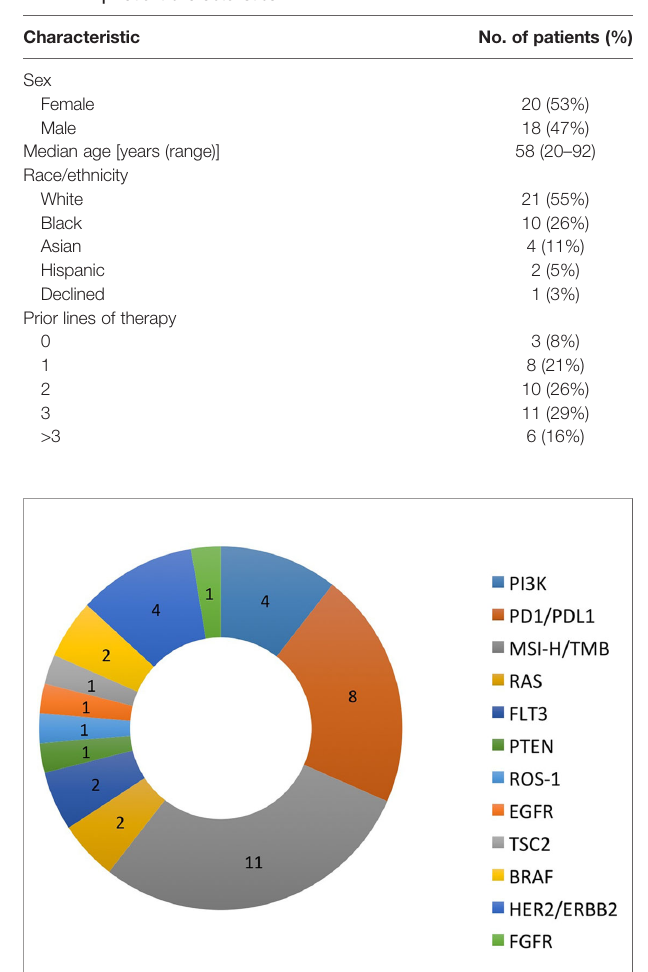
FIGURE 2 | Target gene and